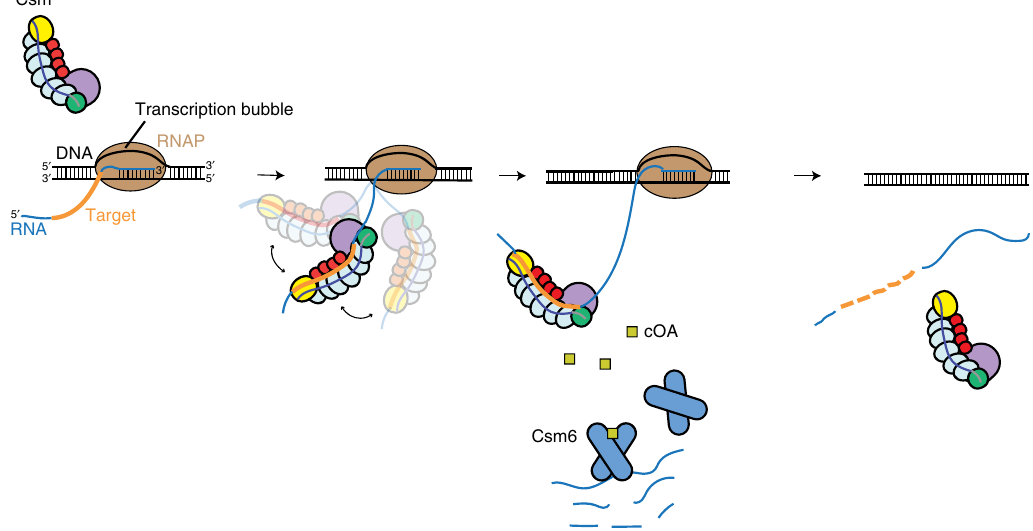
Fig. 6 Model for transcription-dependent immunity by RNA-guided Type III CRISPR-Cas systems. Transcription across a DNA target generates a nascent transcript that is complementary to the crRNA of Csm (complementary target sequence in RNA is colored orange). Binding to the transcript fl exibly tethers TthCsm to the TEC, but does not lead to an interaction of TthCsm with the RNAP or the DNA in the transcription bubble. Csm cleaves transcripts using its Csm3 subunit, instead of cleaving the ssDNA at the transcription bubble. While bound to RNA, Csm also synthesizes cyclic oligoadenylate (cOA) molecules, which binds to and activates the Csm6 RNase for transcript